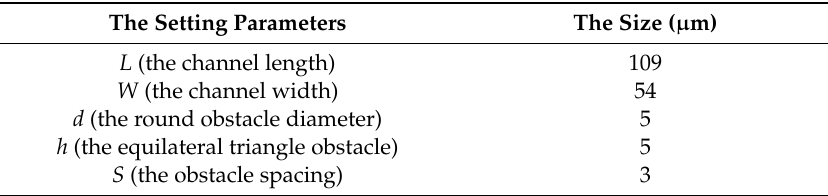
Table 1. The geometric parameters of the DLD array.